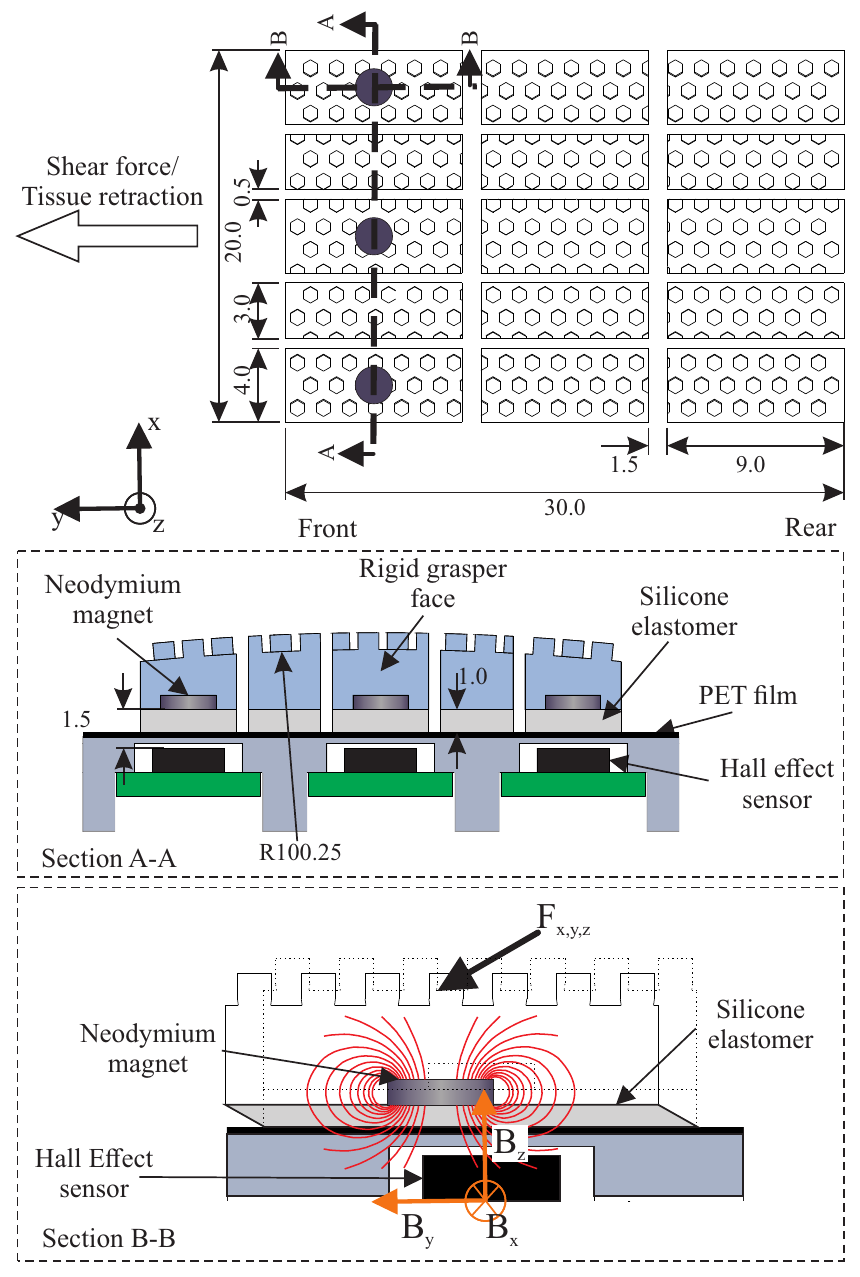
Figure 2. Detailed drawing of grasper design showing independently movable islands; the grey circles indicate the positions of the magnetic sensing nodes (all dimensions are in mm). Section A-A: Cross-section displaying the design of the sensored and passive islands. Section B-B: Cross-section showing how the magnetic field moves through the Hall-effect sensor as force is applied to the